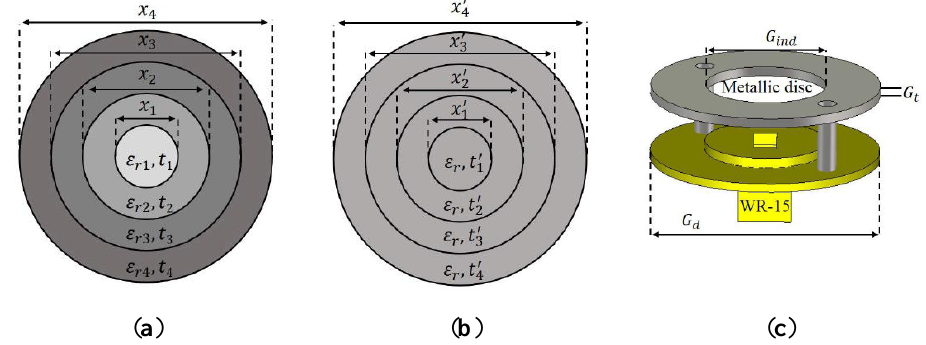
Figure 5. Configuration of a RCA with stepped PRS: ( a ) First PRS configuration; ( b ) Second PRS configuration; ( c ) Entire structure [74].